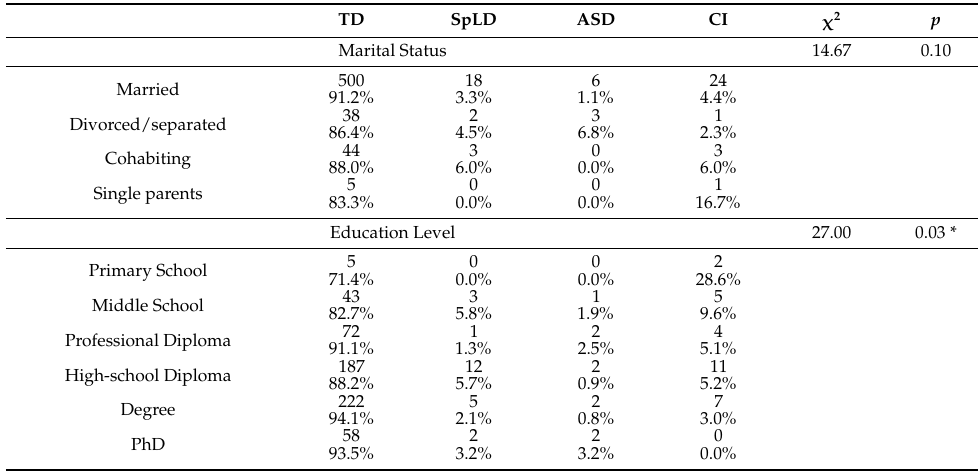
Table 1. Sociodemographic data distinguished for families with typical development (TD), specific learning disorder (SpLD), with autism spectrum disorder (ASD), and chronic illness